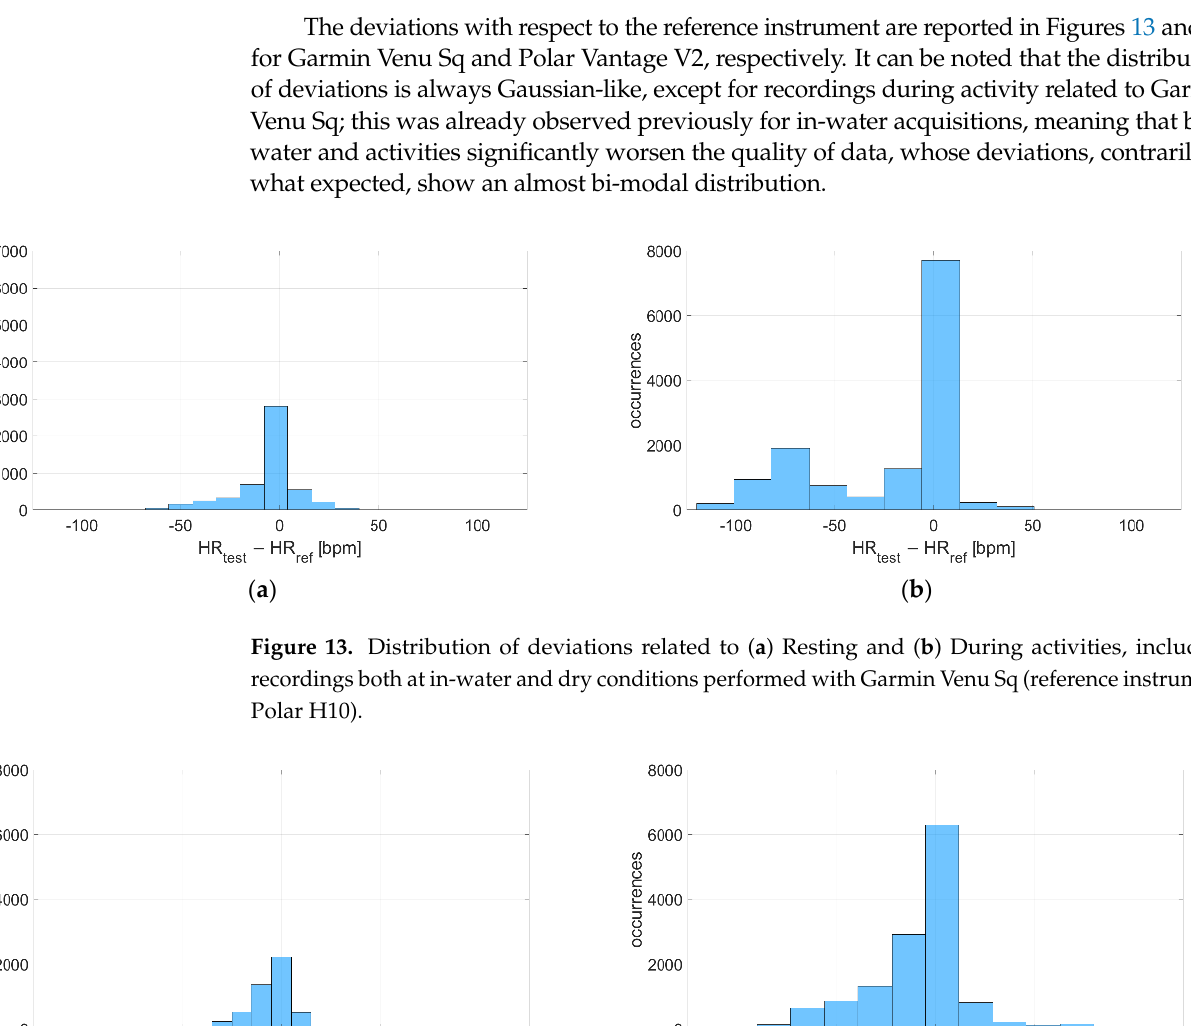
( b ) Figure 12. Bland–Altman plot related to recordings performed ( a ) Resting and ( b ) During activities, including recordings both at in-water and dry conditions performed with Polar Vantage V2 (refer- ence instrument: Polar H10. The deviations with respect to the reference instrument are reported in Figures 13 and 14 for Garmin Venu Sq and Polar Vantage V2, respectively. It can be noted that the distribution of deviations is always Gaussian-like, except for recordings during activity related to Garmin Venu Sq; this was already observed previously for in-water acquisi- tions, meaning that both water and activities significantly worsen the quality of data, whose deviations, contrarily to what expected, show an almost bi-modal distribution. The correlation with the measurements performed through the reference sensor is reported in Figures 15 and 16 for Garmin Venu Sq and Polar Vantage V2, respectively. It